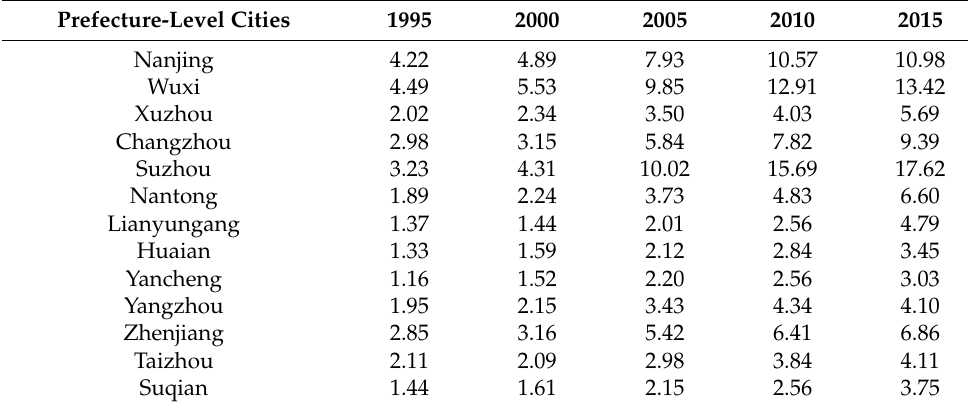
Table A1. EFDs of prefecture-level cities of Jiangsu in 1995–2015.